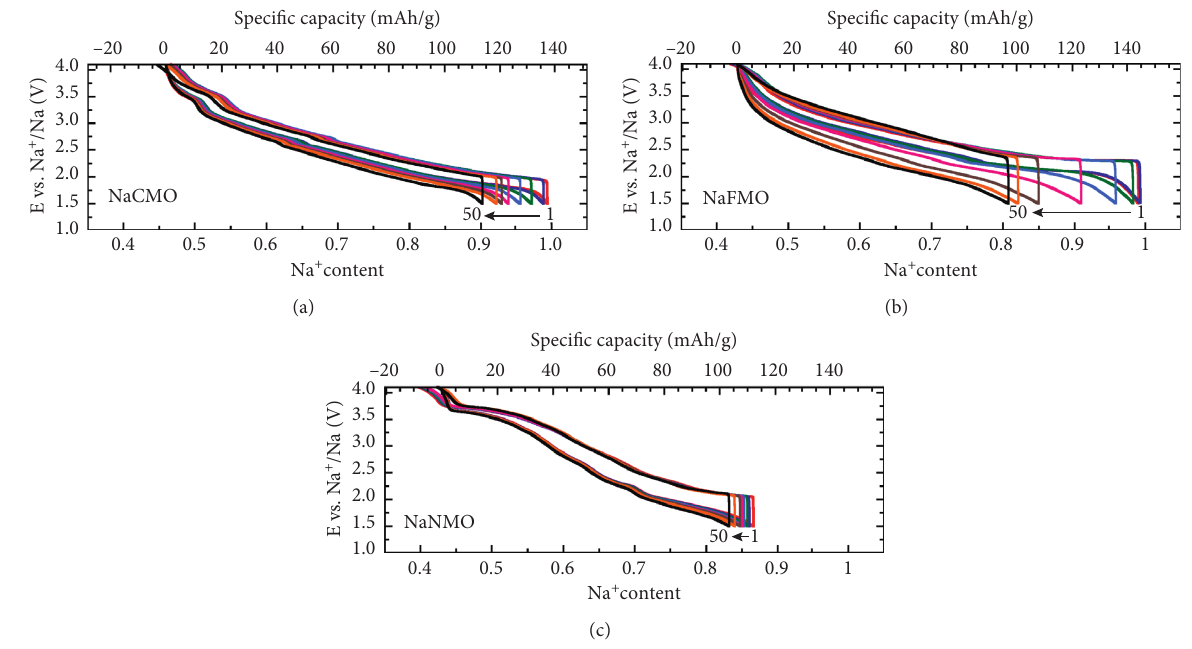
Figure 4: The galvanostatic cycle of NaCMO (a), NaNMO (b), and NaFMO (c) in sodium half-cell.